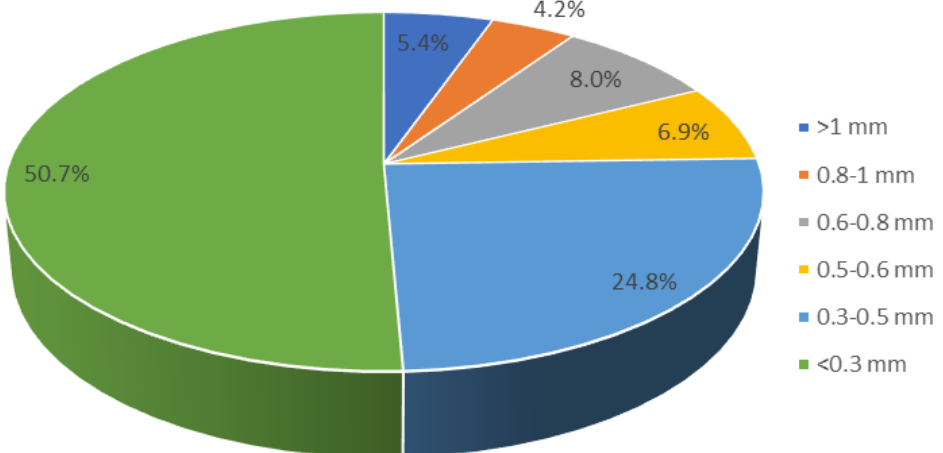
Figure 1. The AN sieve analysis results.